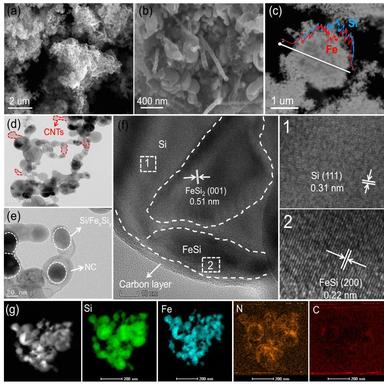
(a, b) SEM images of Si/FexSiy@NC/CNTs-1. (c) STEM and Fe,Si intensity line scan of Si/FexSiy@NC/CNTs-1. (d, e) TEM images of Si/FexSiy@NC/CNTs-1. (f) HR-TEM image of Si/FexSiy@NC/CNTs-1. (g) High-angle annular dark-field STEM image of Si/FexSiy@NC/CNTs-1 and the corresponding EDS elemental color maps of the Si, Fe, N, and C distributions.